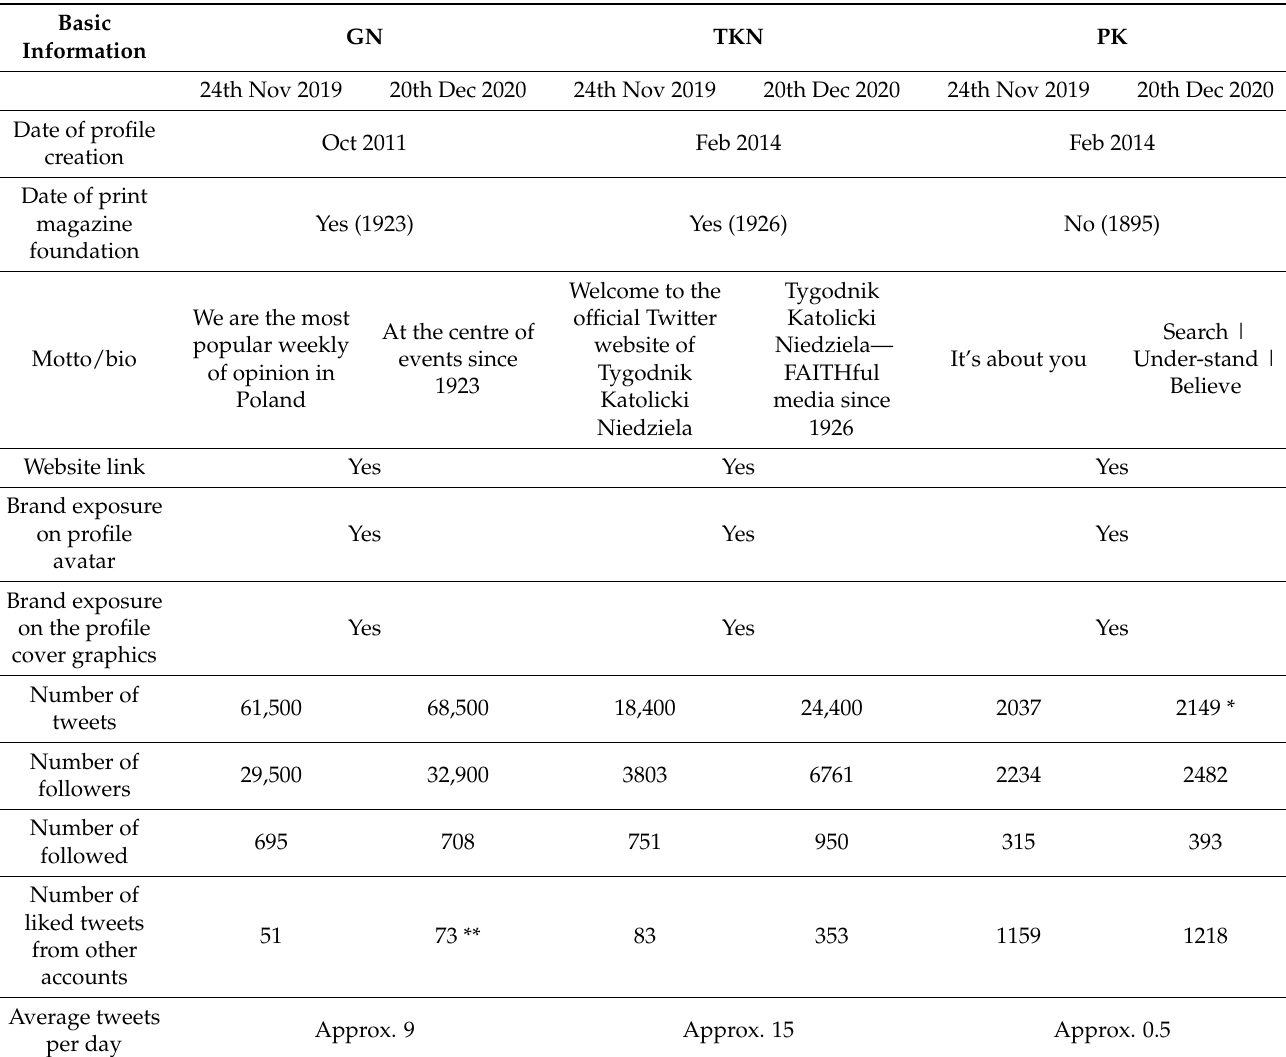
Table 3. Comparison of the profiles—analysis results (24th Nov 2019–24th Dec